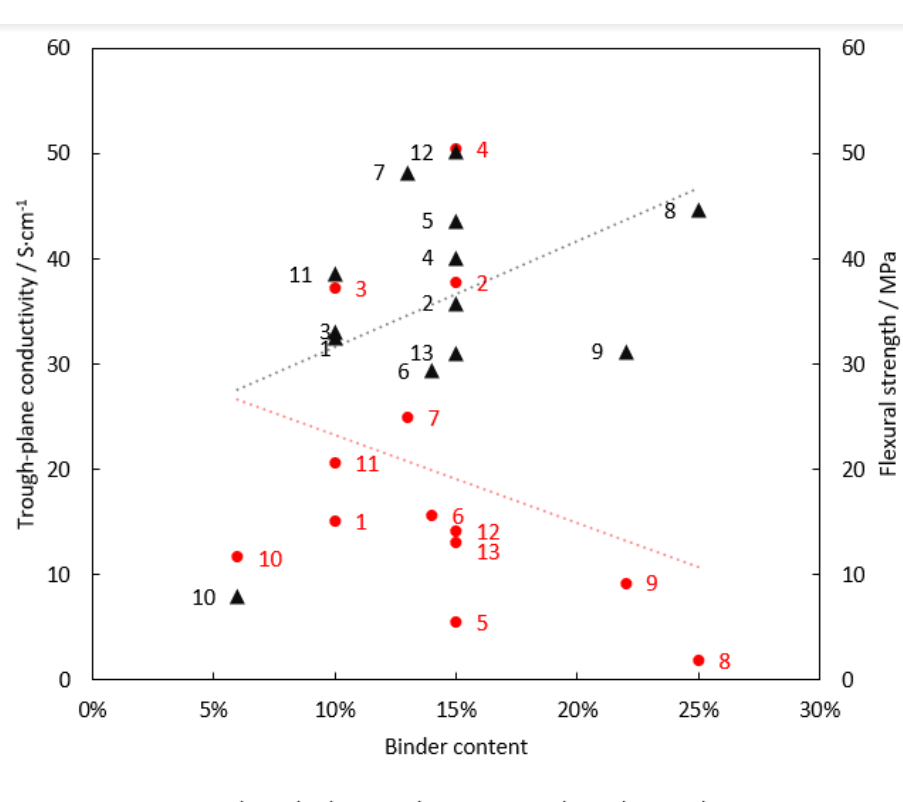
Figure 9. Through-plane conductivity and flexural strength vs. binder content. (1) Eisenhuth BMA 5, (2) Eisenhuth BMA 6, (3) Eisenhuth Melange, (4) Eisenhuth Melange 6, (5) Eisenhuth PP, (6) Eisenhuth PPG 86, (7) Eisenhuth PPS, (8) MEGA Extrusion, (9) MEGA Compression, (10) SGL Carbon TF6, (11) SGL FR10, (12) Shin Etsu BPB-B350, (13) Shin Etsu